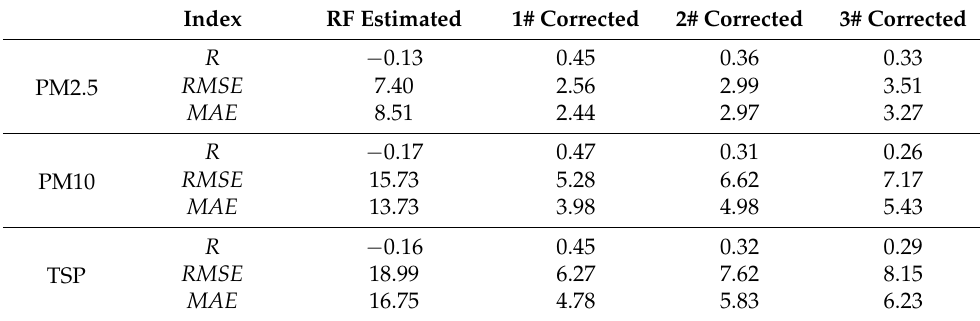
Table 7. Comparison before and after Markov